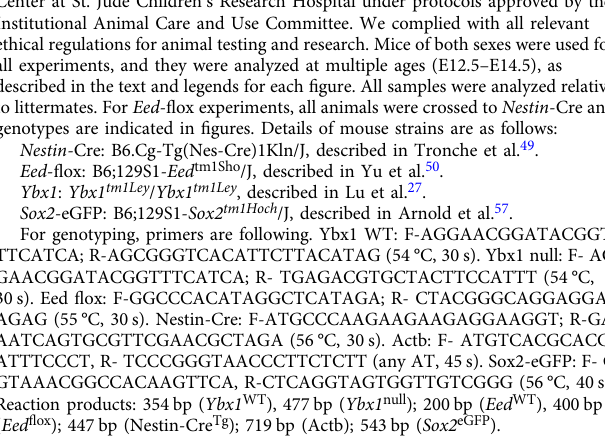
Antibodies . Supplementary Table S1 lists all antibodies and conditions used in this study. Co-immunoprecipitation . For co-immunoprecipation, subcellular fractionation was performed as above, but Buffer D + PI + DTT was substituted for Buffer B and the nuclear fraction was diluted with an equal volume H 2 O + PI + DTT. Approximately 1.5mg of the nuclear extract was incubated with primary antibody overnight at 4°C. Extract and antibody were added to protein A and protein G Dynabeads ™ (ThermoFisher 10002D and 10004D) for 5h at 4 °C, washed